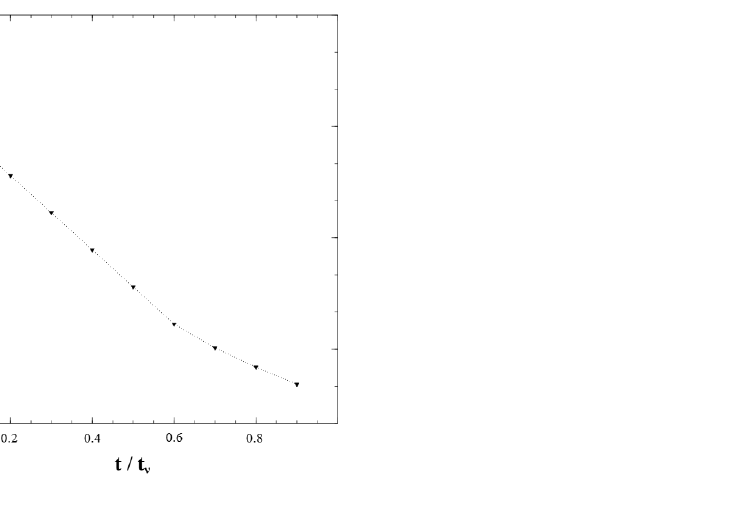
Figure 10. Evolution of the maximum intensity of the spurious currents observed around the bubble. With the use of an exact curvature for the simulation, the equilibrium is reached for a time t ν .